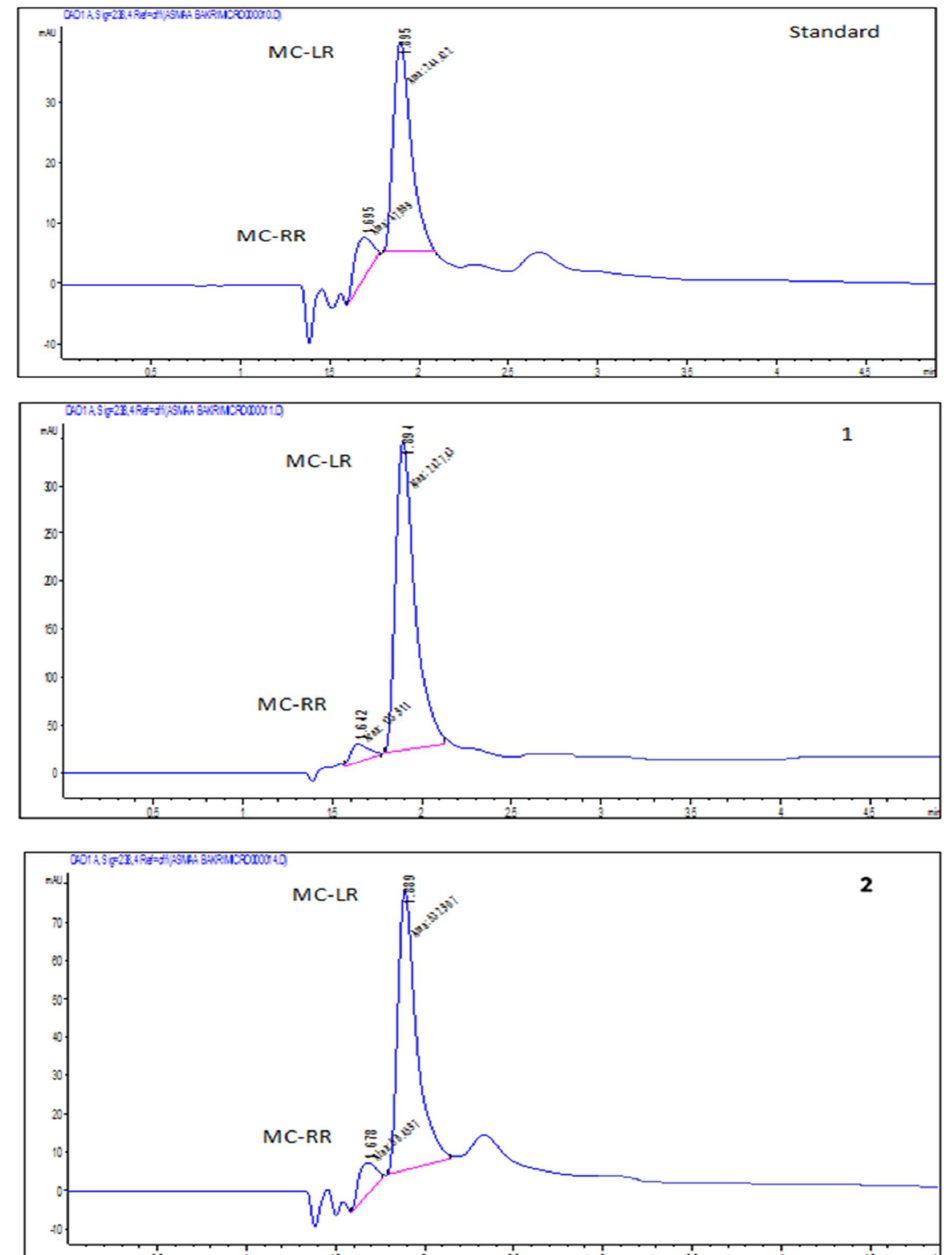
Figure 1. HPLC profile of standard microcystin, extracellular (1) and intracellular (2) MCs produced from Oscillatoria limnetica Lemmermann isolated from some of the water sources used in irrigation of crop plants in Sohag district.